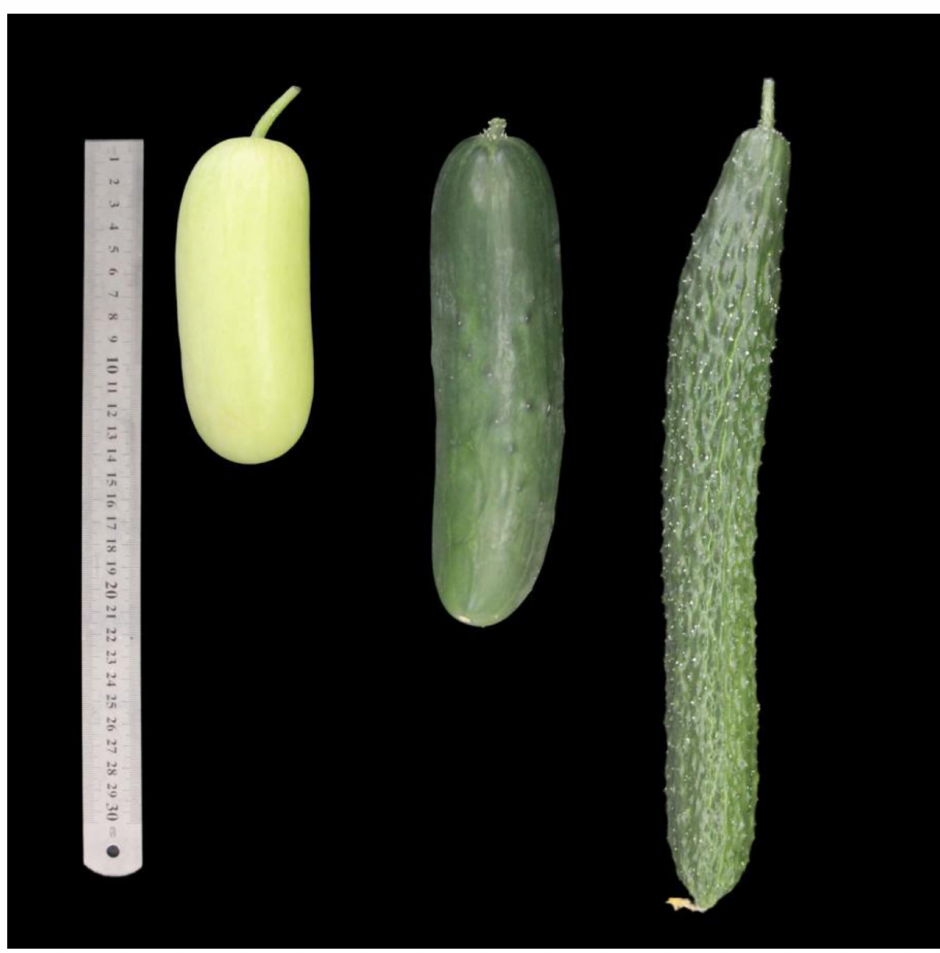
Figure 1. Image of the three cucumber cultivars selected for HS-SPME/GC–MS analysis. From left to right: YX, GX, and